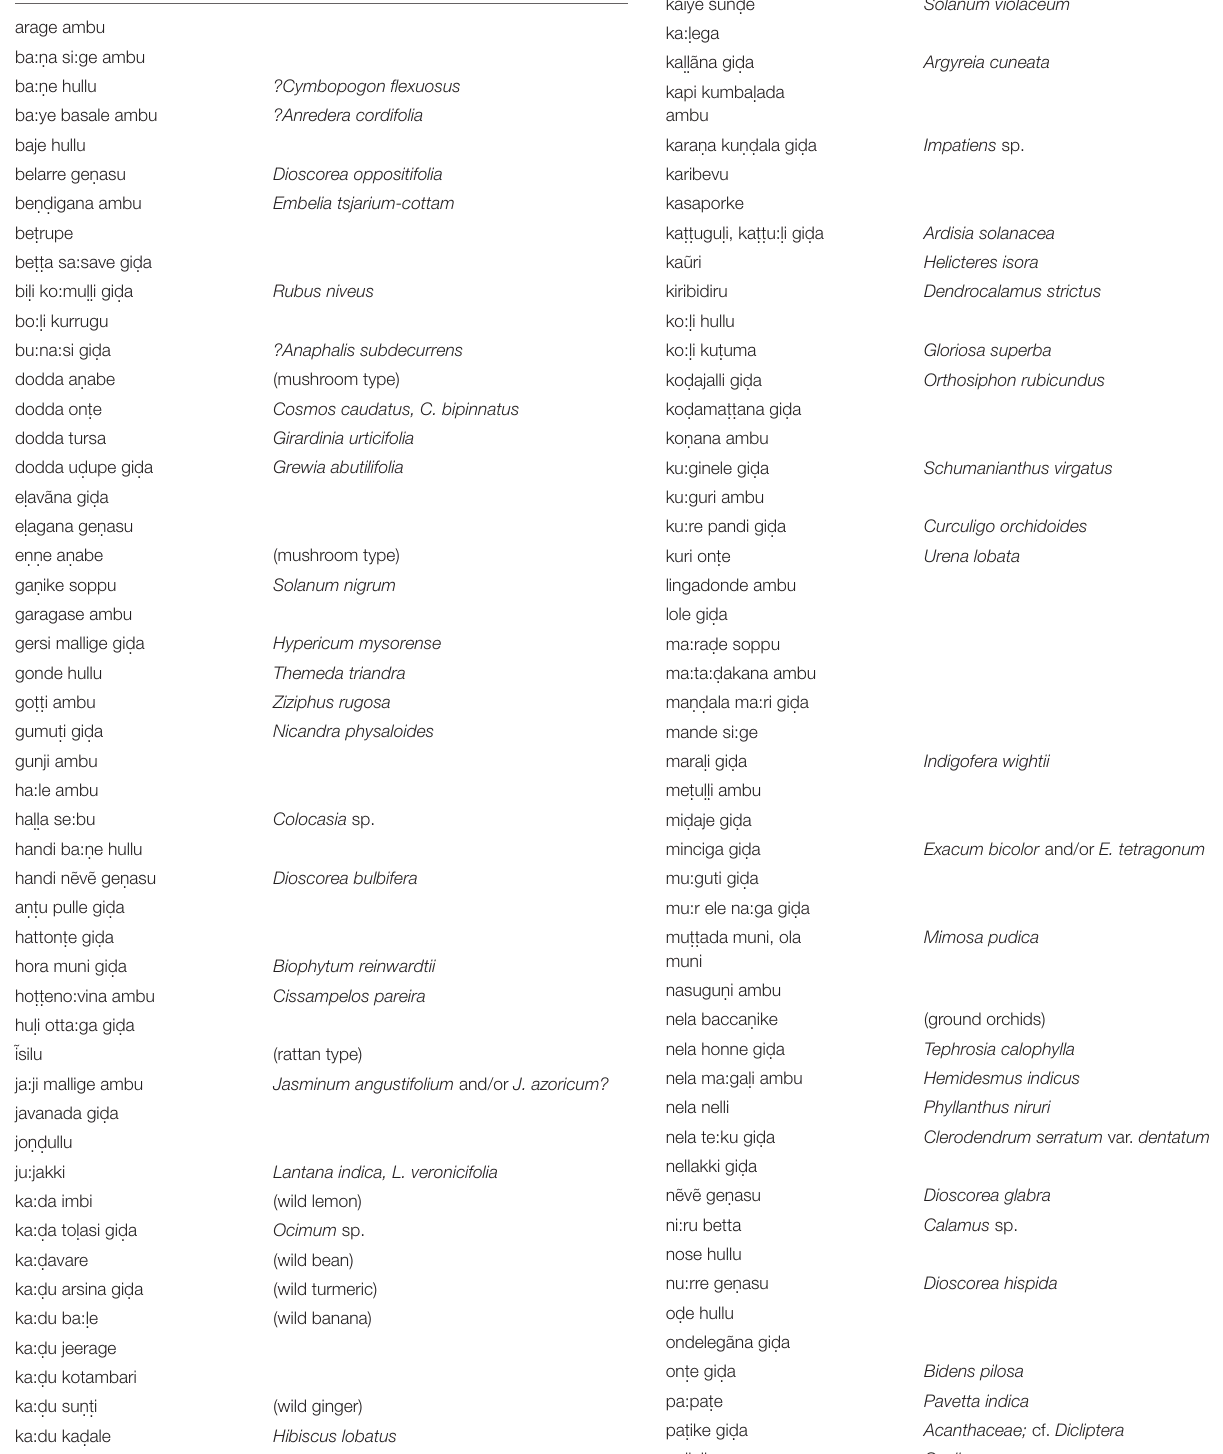
TABLE 1 | Plants identified by Solega consultants as being rare or locally extinct nowadays, along with scientific identifications (if